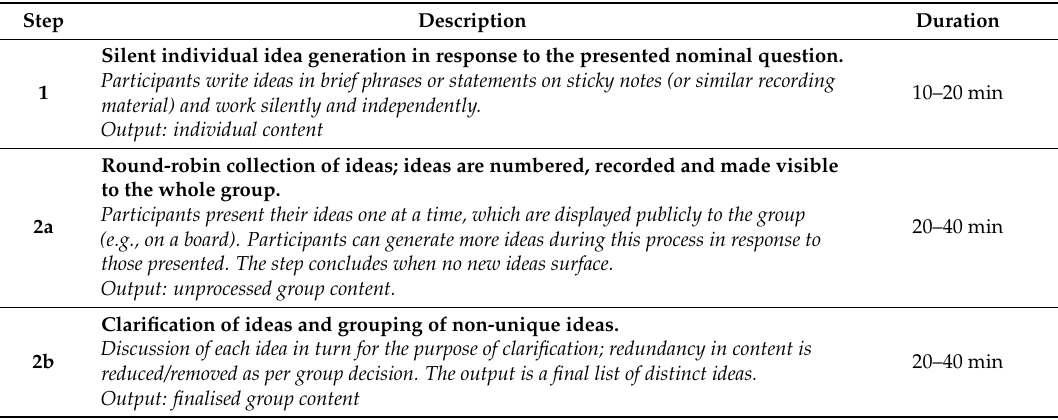
Table 1. Main steps in executing the Nominal Group Technique (NGT) (adapted from